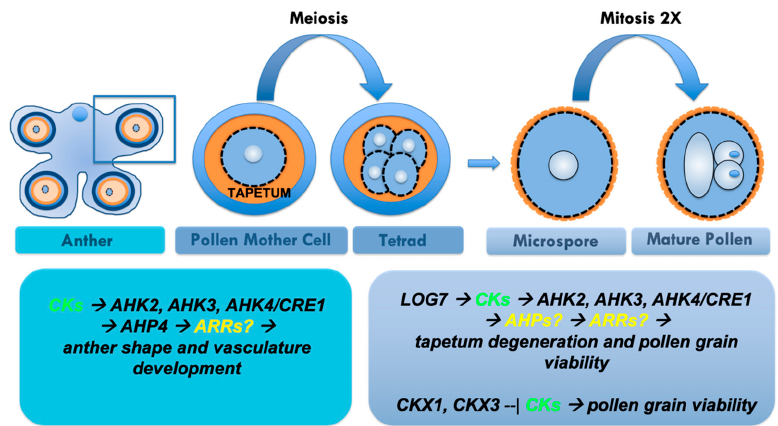
Figure 4. CK biosynthesis, degradation and signalling components during stamen and pollen development. This cartoon depicts the most important phases of pollen development inside Arabidopsis anther. The first step begins when the diploid pollen mother cell enter meiosis and give rise to a tetrad of haploid microspores that subsequently enter two rounds of mitosis: first round is asymmetrical forming the vegetative and germ cells, the second symmetrical only in the germ cell and gives rise to the sperm cells. The involvement of CKs in pollen development starts at the beginning of anther formation because anthers have to acquire a lobed shape and CK receptor mutants exhibit defects in anther